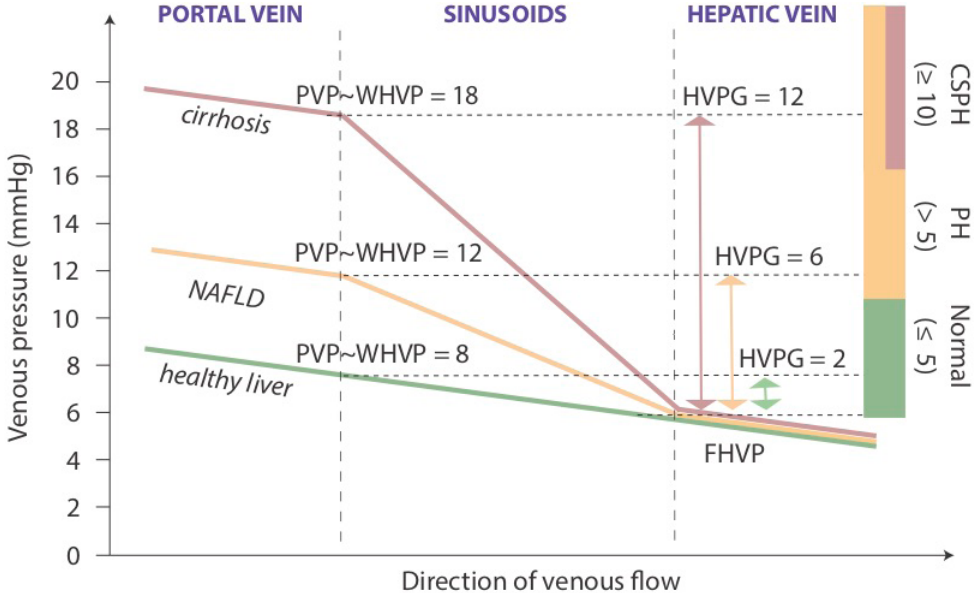
Figure 3. Portal and hepatic venous pressure in sinusoidal portal hypertension. Schematic diagram with representative examples of PVP changes across the liver in health, NAFLD and cirrhosis. Colored bars on the right indicate ranges of PVP defined